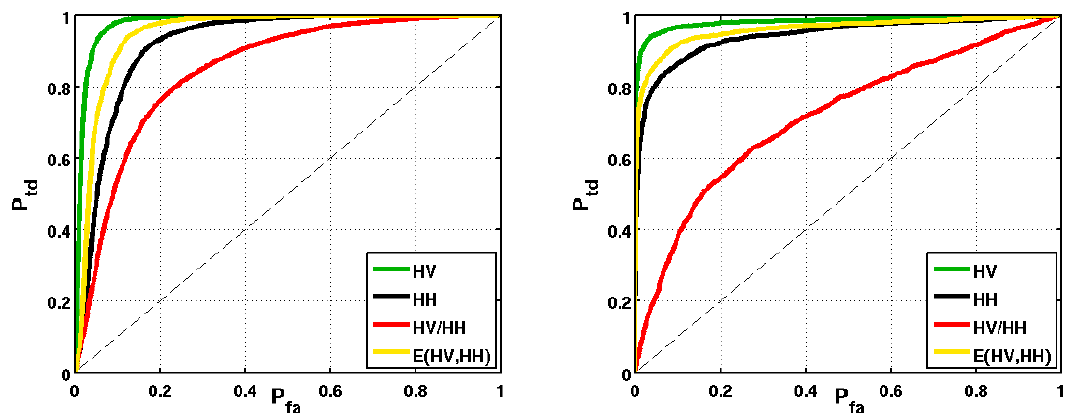
Figure 3. Receiver operating characteristic (ROC) plot comparison of γ HV , γ HH , γ HV / γ HH and E( γ HV , γ HH ), where E is the average value. ( Left ) Forest disturbances versus intact forest detection; and ( right ) forest regrowth versus intact forest